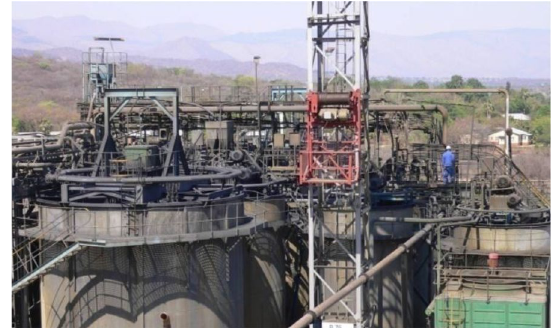
Fig. 1 Commercial-scale BIOX ® bioleaching process in Barberton, South Africa (Kaksonen et al. 2014). [Image courtesy of Dr. Anna